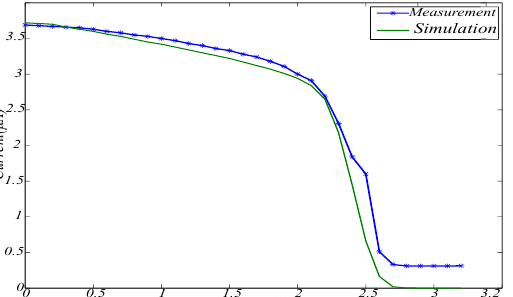
Figure 17. Measurement and simulation results of total power consumption when V 2 is 0 V and V 1 increases from Gnd to Vdd .